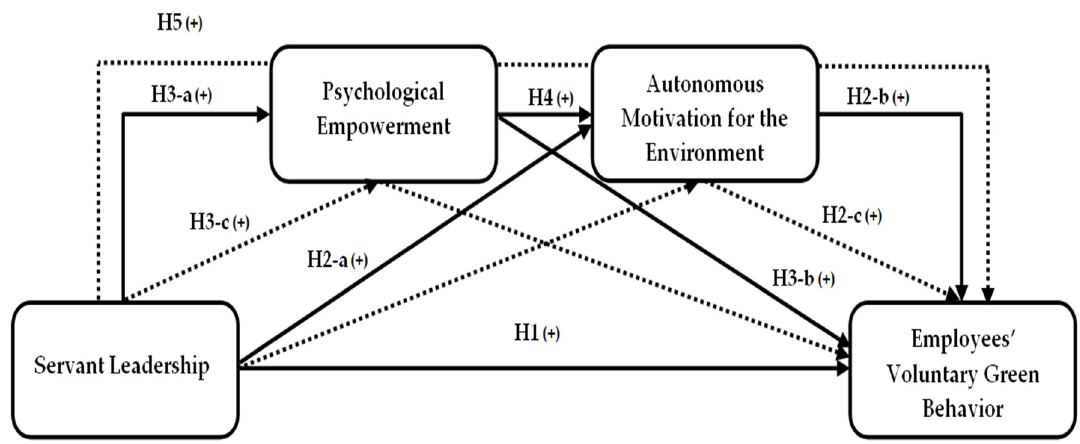
Figure 1. Hypothesized Model. Note: Plain lines represent the direct relationships, while dotted lines show the mediation relationships.